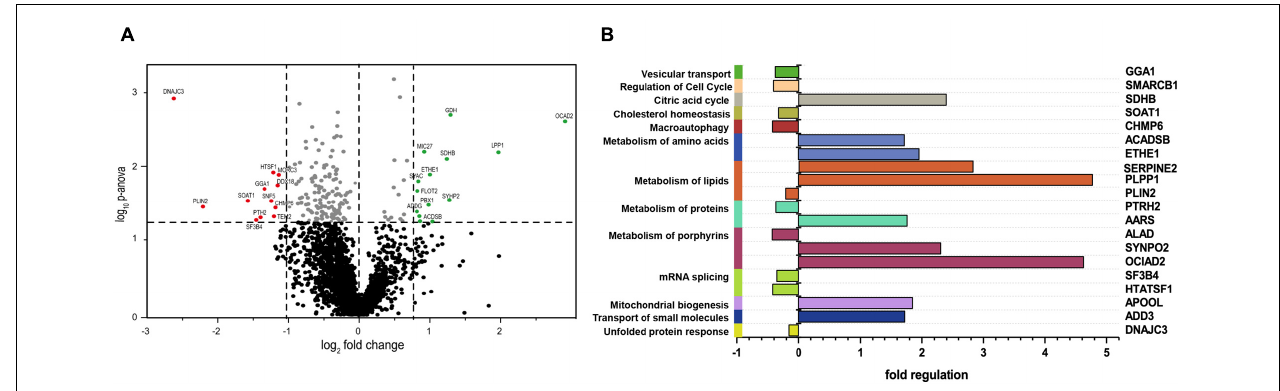
FIGURE 1 | Comparative proteomic profiling results of DNAJC3 -patient-derived fibroblasts versus control ones. (A) The volcano plot depicts all proteins identified in fibroblasts, making a clear delimitation between the statistically significant and non-significant quantified proteins ( p -ANOVA < 0.05; horizontal line). Proteins with decreased abundances are represented in red, while the upregulated ones are highlighted in green color. (B) In silico analyses of proteomic findings included pathway analysis of the regulated proteins. All proteins with altered abundances were searched using KEGG, DAVID, and Reactome databases for protein pathway annotation. Vulnerable pathways (left Y -axis) were color-coded and referred to affected proteins (right Y -axis). Fold of regulation of the individual proteins is indicated on the X -axis. GGA1, ADP-ribosylation factor-binding protein GGA1; SMARCB1, SWI/SNF-related matrix-associated actin-dependent regulator of chromatin subfamily B member 1; SDHB, succinate dehydrogenase; SOAT1, Sterol O -acyltransferase 1; CHMP6, charged multivesicular body protein 6; ACADSB, short/branched chain specific acyl-CoA dehydrogenase; ETHE1, persulfide dioxygenase ETHE1; SERPINE2, Glia-derived nexin; PLPP1, phospholipid